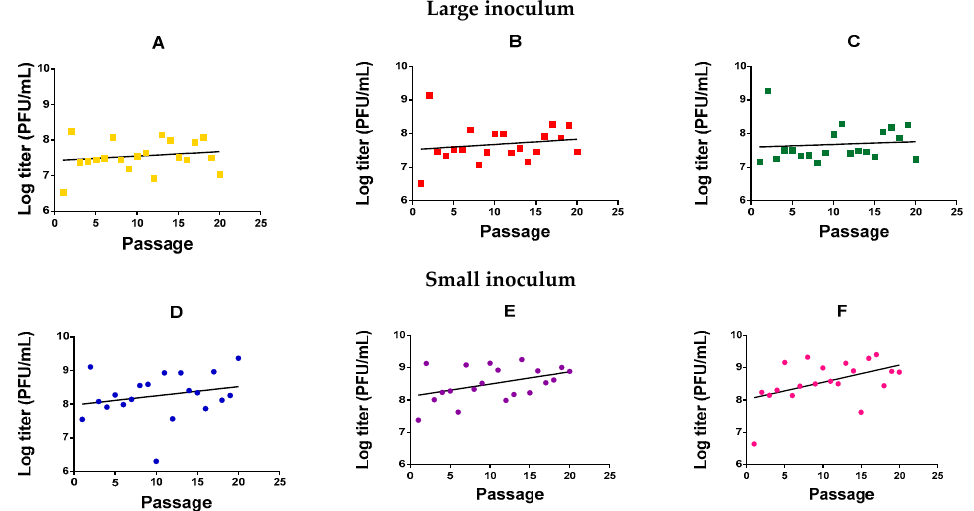
Figure 1. Log-titer reached after each passage of mycobacteriophage evolution. Large inoculum: ( A ) Yellow, ( B ) red, ( C ) green. Small inoculum: ( D ) Blue, ( E ) purple, ( F ) pink. Dots: Experimental points. Line: Linear regression.